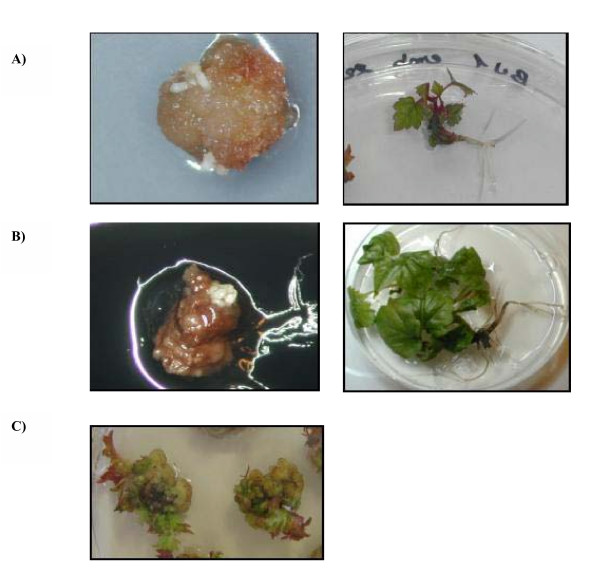
Somatic embryogenesis and shoot organogenesis of Vitis vinifera Chardonnay 96. A) Embryogenic callus from anthers and plant regeneration, B) Embryogenic callus from nodal explants and plant regeneration, C) Shoot organogenesis from meristematic bulk.